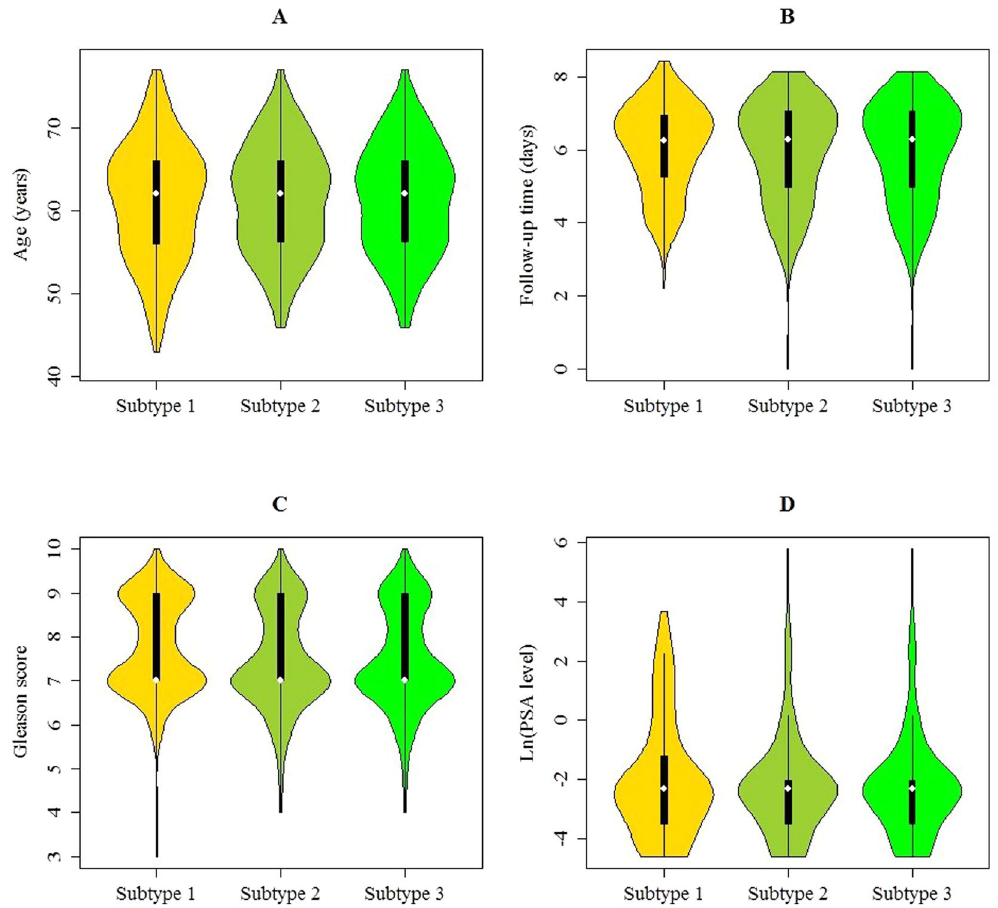
Figure 5. The violin plots of ( A ) patient age, ( B ) follow-up time, ( C ) Gleason score, and ( D ) PSA level for the robust